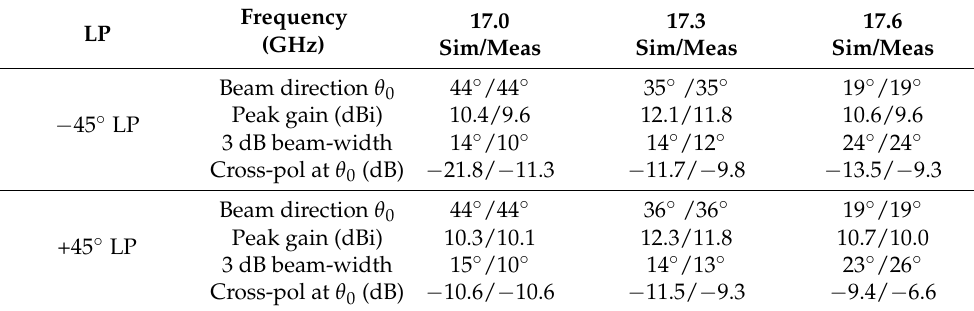
Figure 19. The measured co–pol and cross–pol gains of the proposed antenna when excited at Port 4 for the frequency range of ( a ) 16.9 GHz–17.2 GHz and ( b ) 17.3 GHz–17.6 GHz in the x–z plane. Table 2. Measured and simulated results of LP.